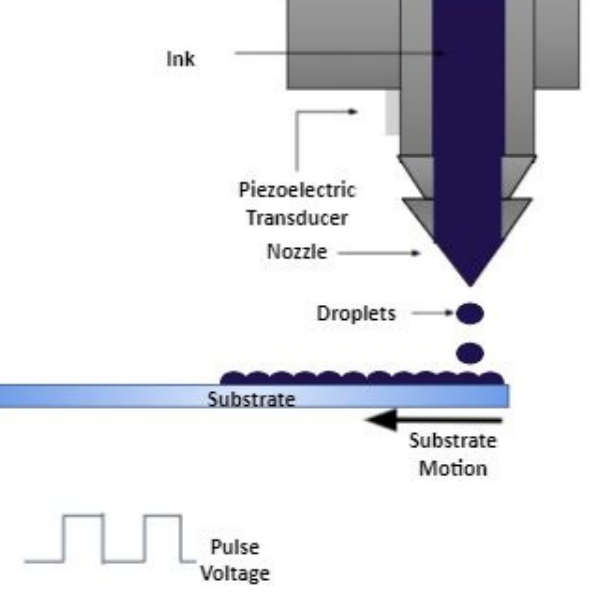
Figure 20. Inkjet printing method.